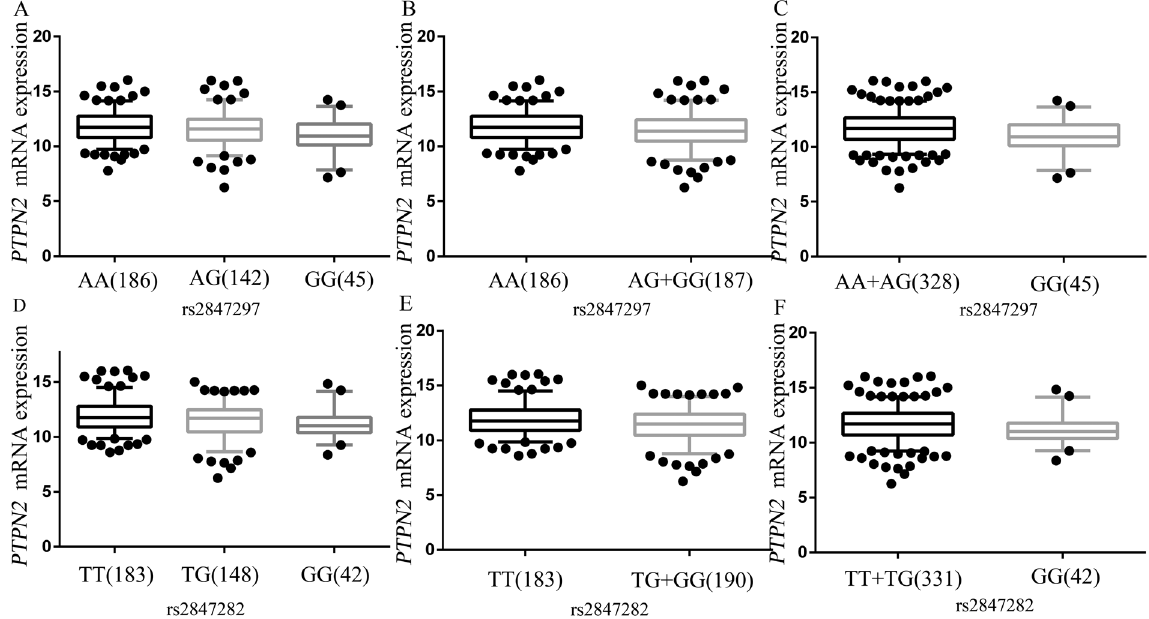
Figure 2. The correlations between identified SNPs and PTPN2 mRNA expression. rs2847297 in PTPN2 ( A ) additive model, P = 0.002; ( B ) dominant model, P = 0.017; ( C ) recessive model, P = 0.005) and rs2847282 in PTPN2 ( D ), additive model, P = 0.0006; ( E ) dominant model, P = 0.001; ( F ) recessive model, P =